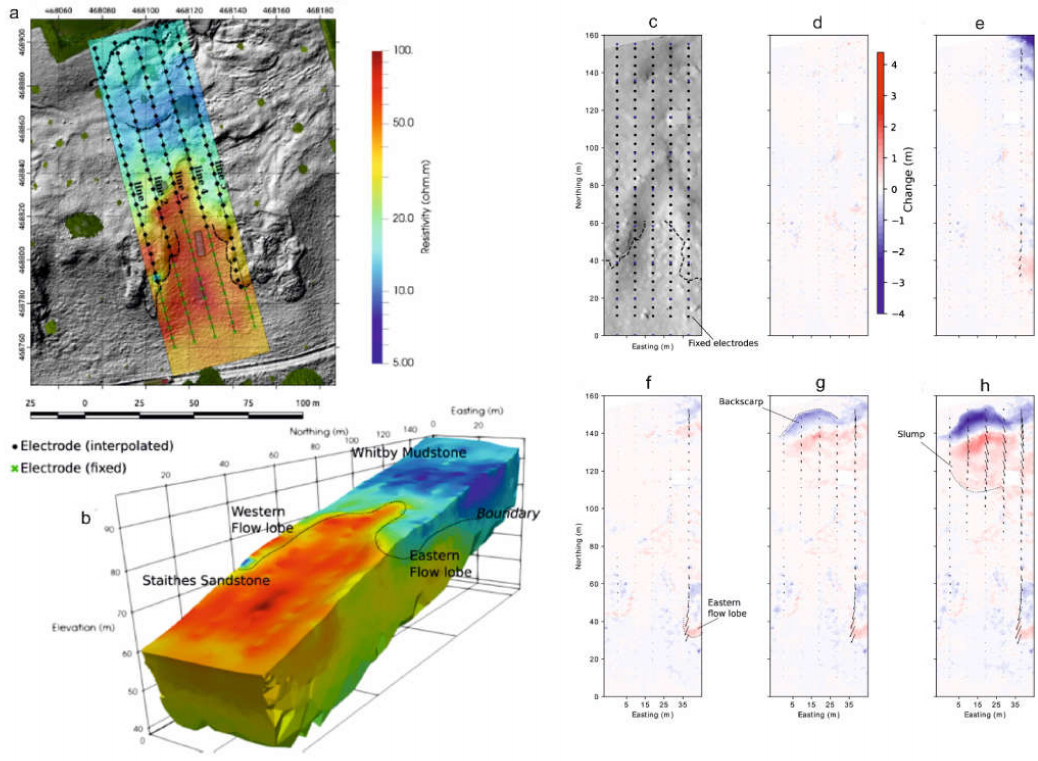
Figure 6. ( a ) The baseline inverted image of the Hollin Hill landslide (southern Howardian Hills, UK) measured in May 2016; ( b ) surface resistivity in relation to a hill-shaded relief map from a UAV survey in May 2016. The six images on the right ( c – h ) report an overview of elevation and electrode coordinate changes at Hollin Hill, as captured by terrestrial LiDAR (after